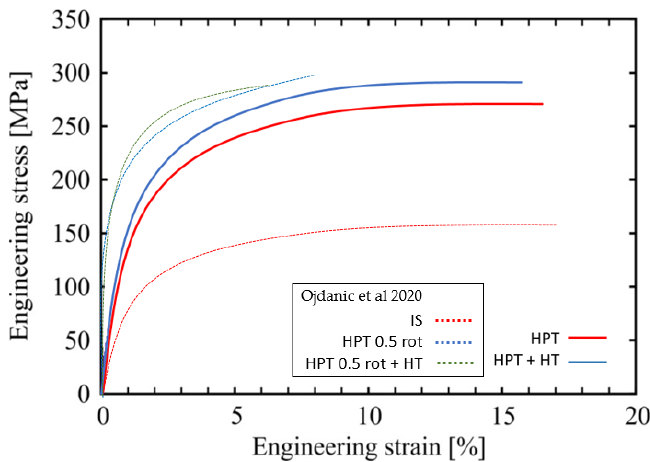
Figure 6. Representative tensile stress-strain curves for Mg5Zn0.15Ca, HPT-processed (10 rotations at 285 °C) (full line—red) and after additional heat treatment at 100 °C for 24 h (full-line blue). For comparison, the dotted lines show the results of the previous study [15] of the same alloy processed as follows: annealing at 450 °C for 24 h and then furnace cooled to RT (IS), HPT-processed at 4 GPa and 0.5 rotations at RT (HPT 0.5 rot), and HPT plus heat treatment at 100 °C for 24 h (HPT 0.5 rot +HT). Table 3. Measured yield strength σ yield and ultimate tensile strength (UTS), as well as ductility (total elongation) ε total for all tested alloys in all conditions (‘HPT’ at 4 GPa, 10 rotations at 285 °C and heat